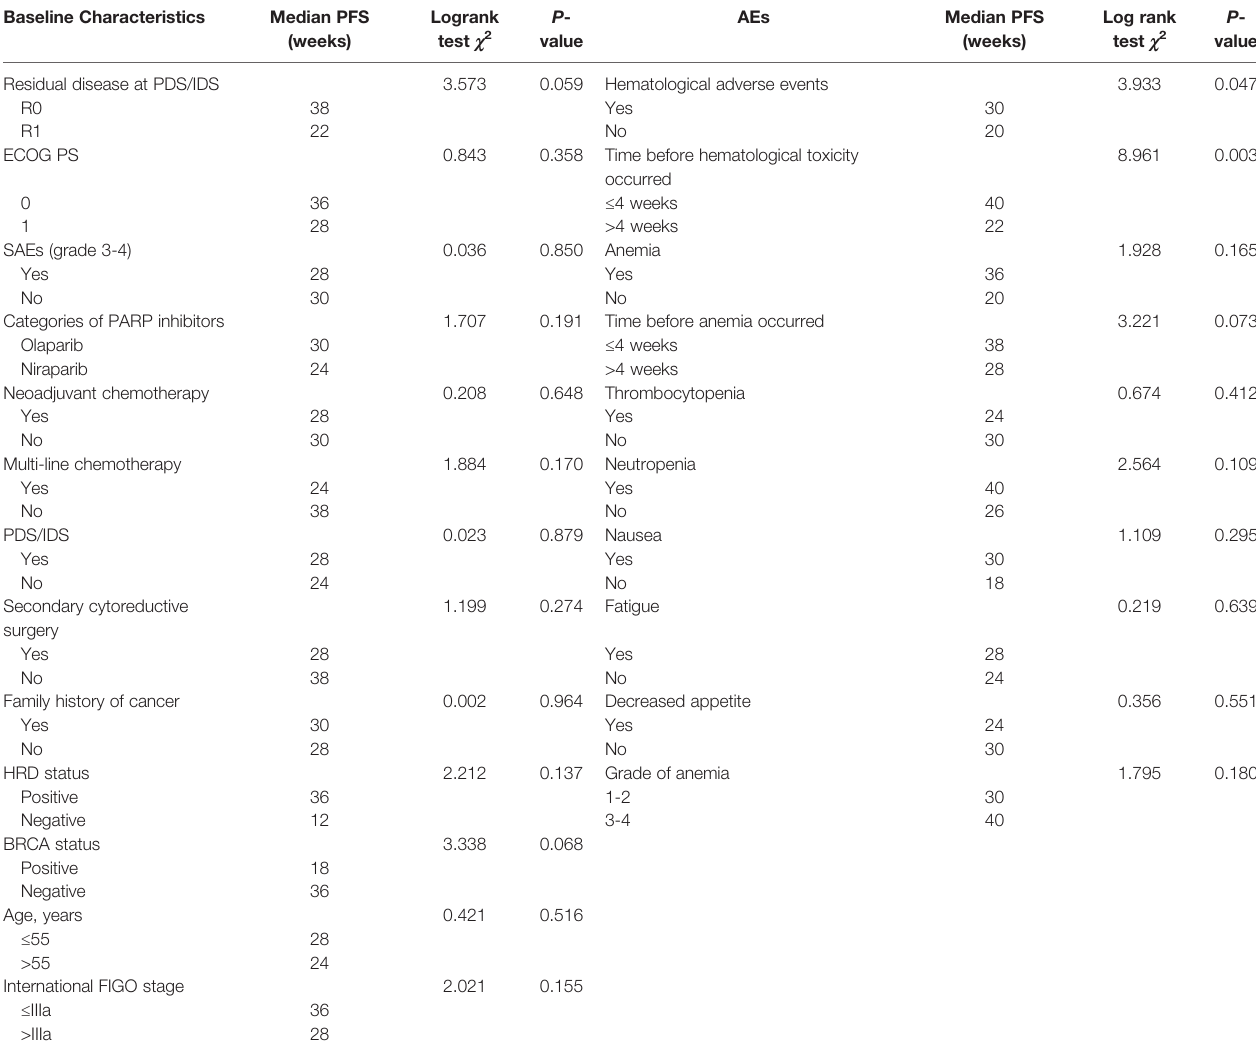
TABLE 3 | Median progression-free survival of patients with different baseline characteristics and adverse events. Baseline